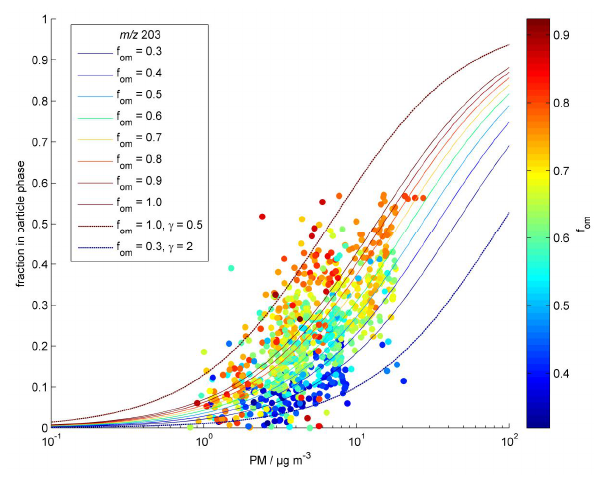
Fig. 9. Measured gas-to-particle partitioning of m/z 203 with Figure 9. Measured gas-to-particle partitioning of m/z 203 with colour coded organic matter 3 colour-coded organic matter fraction. All modelled functions are fraction. All modelled functions are based on the average fit of all data points with the 4 based on the average fit of all data points with the average campaign average campaign of f om =0.64 and (cid:534) =1. The measured data points are averaged on a basis of 5 of f om = 0 . 64 and γ = 1. The measured data points are averaged on 30 minutes. 6 a basis of 30min. up strong intermolecular binding forces (hydrogen